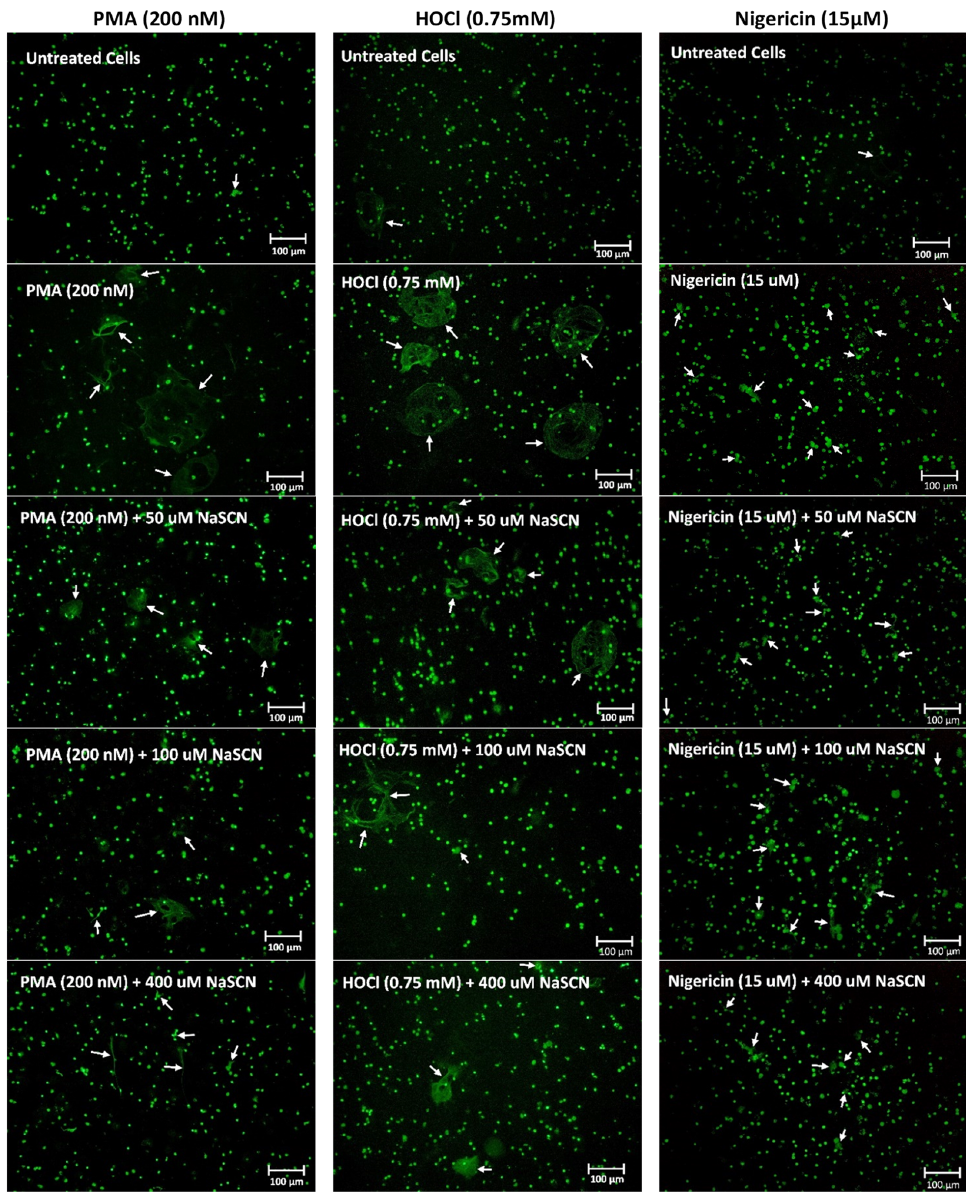
Figure 5. Microscopy of differentiated PLB-985 cells pre-treated with SCN − prior to NET stimulation. Differentiated PLB-985 cells (4 × 10 5 ) were treated with increasing concentrations of SCN − for 15 min at 37 °C prior to the stimulation of cells with PMA (200 nM), HOCl (0.75 mM) or nigericin (15 µM) for 4 h. After the treatment, the cells were fixed in 4% formaldehyde for 30 min and the DNA was stained with SYTOX green (2 µM) for 10 min in the dark. The NETs are indicated by the white arrows. Images are representative of at least 3 independent experiments.